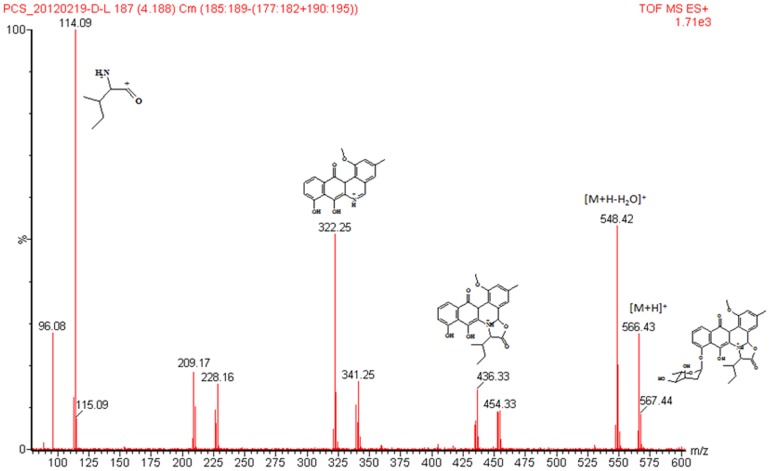
Mass spectrum of selected ion at tR 4.18 min in TIC.